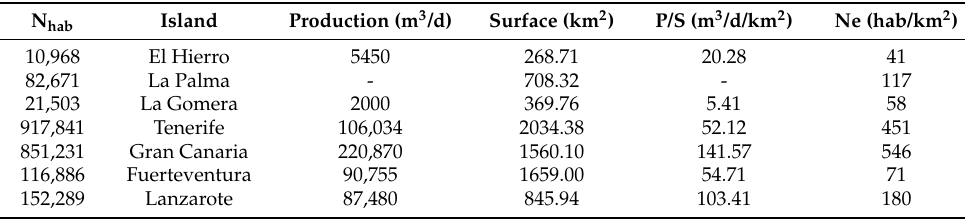
Table 13. Production of the existing seawater desalination plants in the Canary Islands, useful area, production per area, and number of habitants per area (2013). N hab